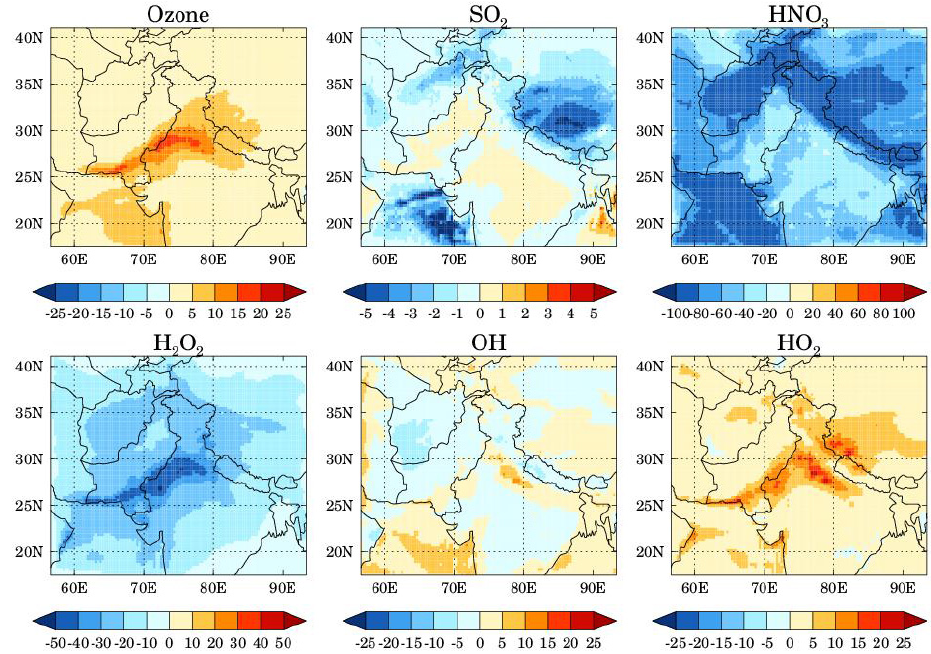
Figure 9. Spatial distributions of relative percentage differences in O 3 , SO 2 , HNO 3 , H 2 O 2 , OH and HO 2 mixing ratios at the surface between Dust_JH and Dust_JH_NoRH configurations during 17–22 April 2010.